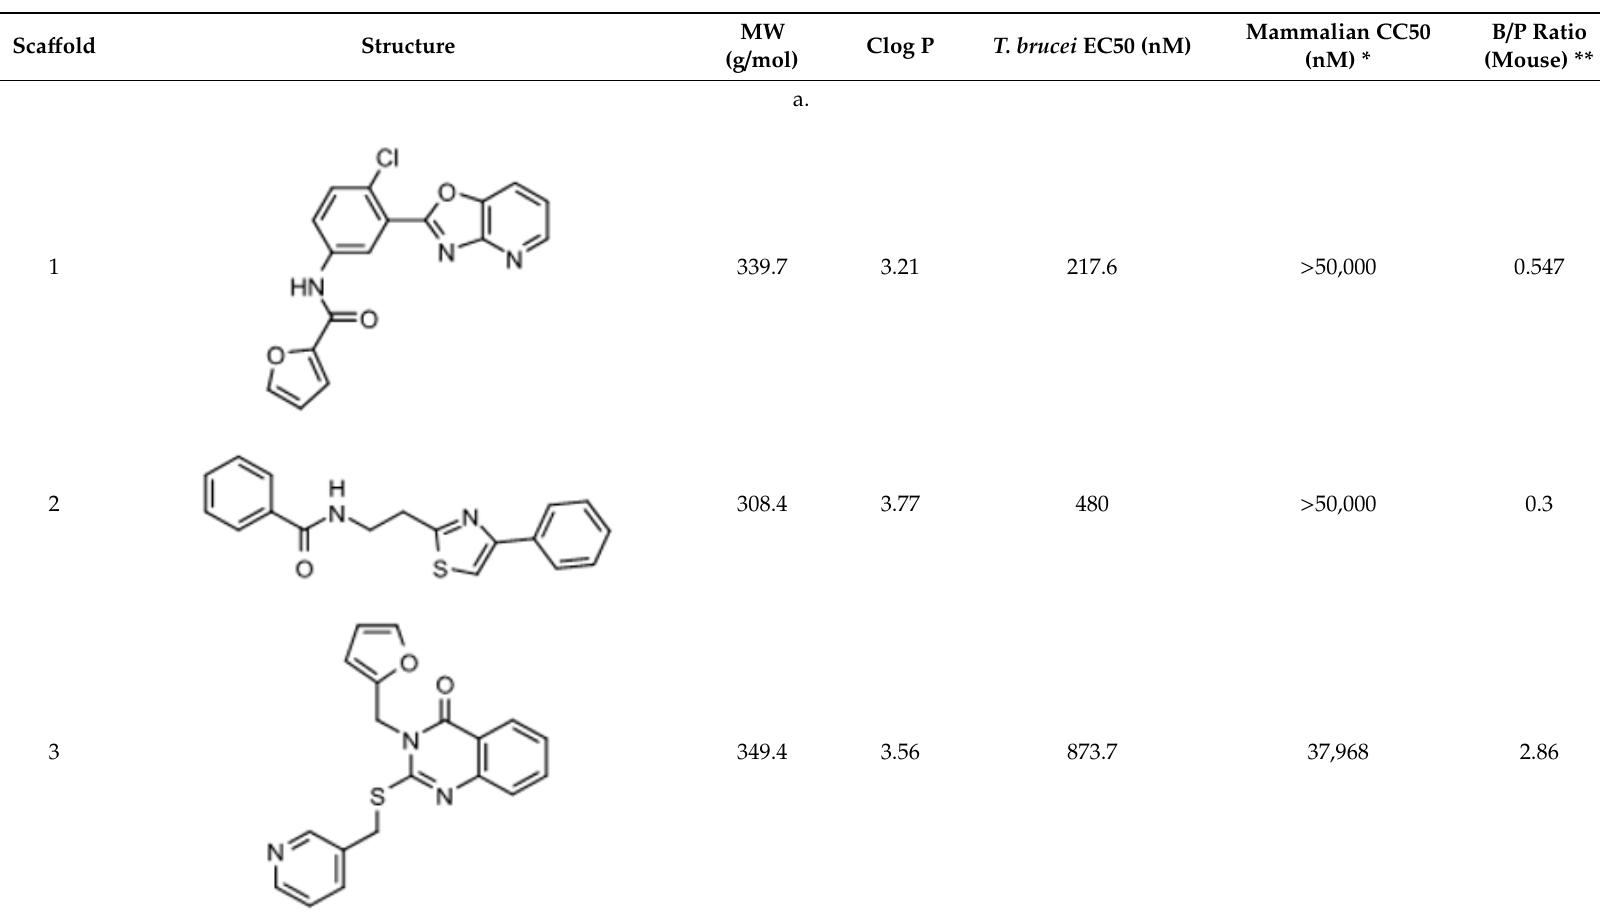
Table 1. a. Structures, properties, and screening results of the 17 selected hit compounds. b. Structures, properties, and screening results of the 17 selected hit compounds.